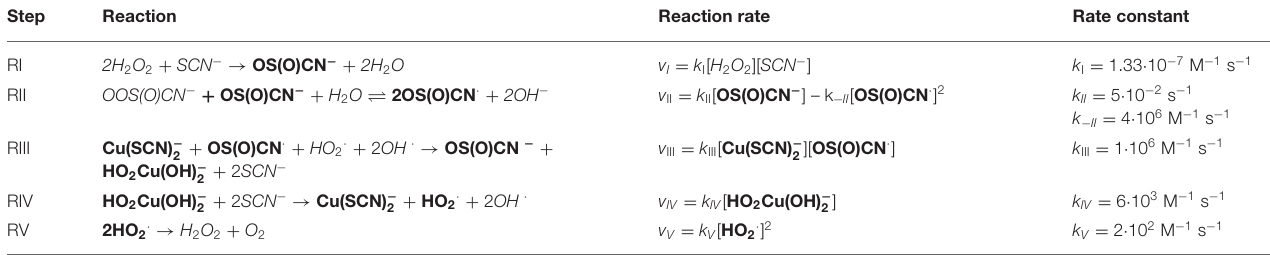
TABLE 3 | The five variables model of the H 2 O 2 –SCN − –Cu(II) system (Wi´sniewski et al., 2015). Step Reaction Reaction